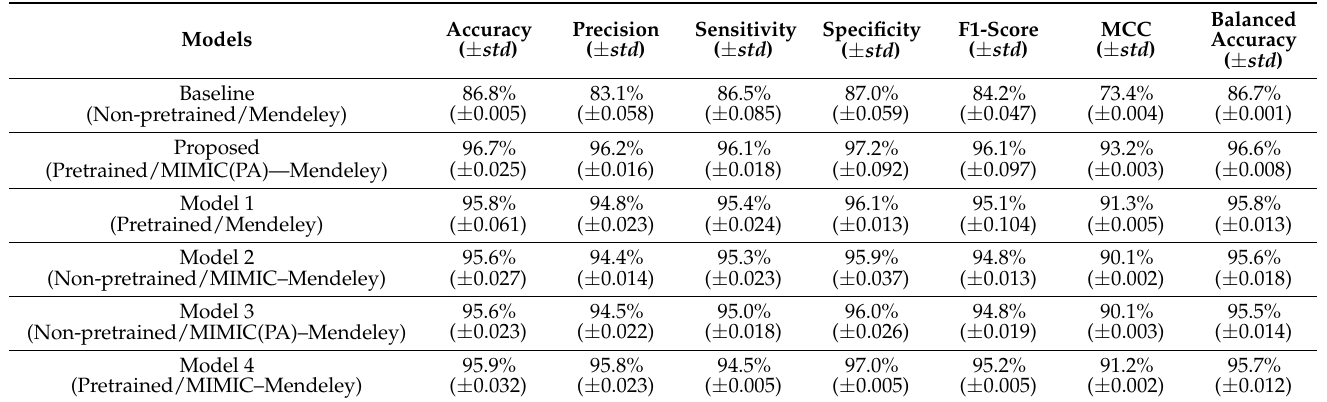
Table 8. Results of comparative experiments.